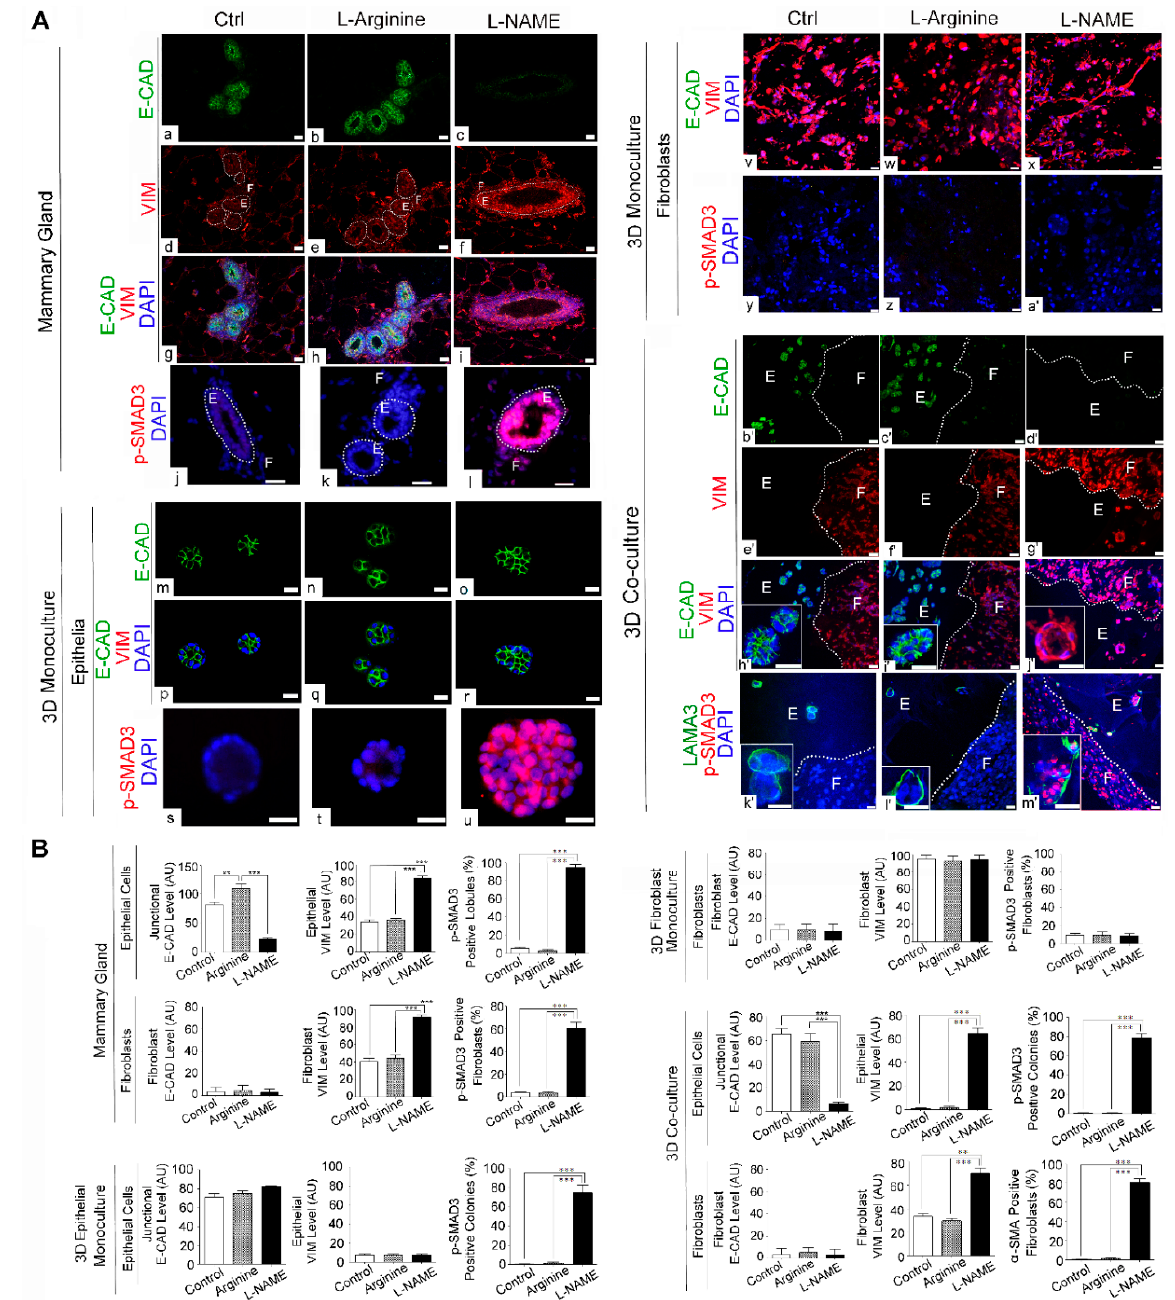
Figure 5. L-NAME treatment elevates TGF- β signals and induces epithelial-to-mesenchymal transition in mammary glands as well as in 3D co-cultures. ( A ) Representative micrographs of drug-treated mouse mammary glands ( a – l ); 3D mono-cultured epithelia ( m – u ); fibroblasts ( v – a’ ); and 3D co-cultures ( b’ – m’ ) as in Figure 3 (Control, L-arginine-treated and L-NAME-treated). Co-stained for E-cadherin (E-CAD, epithelial marker) and vimentin (VIM, fibroblast marker) (( a – i ), ( m – r ), ( v – x ), ( b’ – j’ )). Stained for p-SMAD3, an indicator of TGF- β signaling (( j – l ), ( s – u ), ( y – a’ ), ( v’ – m’ )). (Panels j–l, s, t were adapted from Ren et al. [23] with permission of Springer Nature.) Insets show representative epithelial colonies. White dotted lines separate MECs (E, glandular epithelial structures) vs. MFs (F, connective tissues). Note that L-NAME treatment downmodulated E-CAD expression, but upregulated VIM expression in the epithelia, indicating epithelial-to-mesenchymal transition (EMT). L-NAME-induced EMT coincided with elevated TGF- β signaling (increase in p-SMAD3), the major activator of EMT as well as fibrogenesis. ( B ) Quantification of signal intensity of different markers shown in micrographs of A in epithelia vs. fibroblasts. Data are presented as the arithmetic mean ± SEM. ** p < 0.01; and *** p <